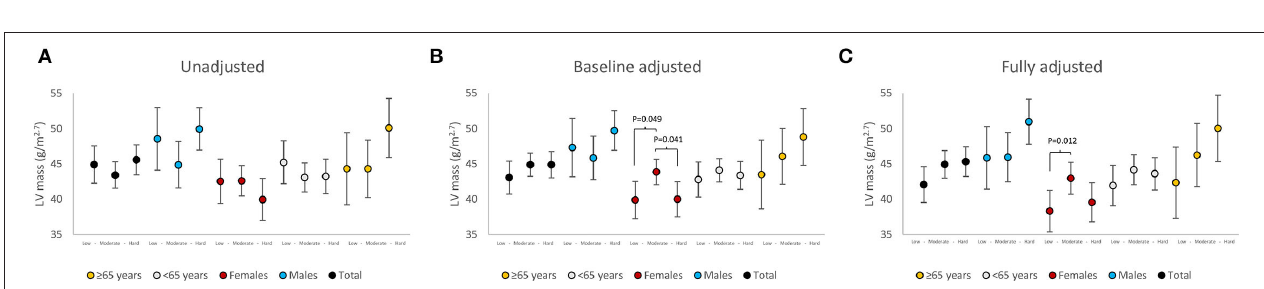
FIGURE 5 | Associations between cumulative PA and cross-sectional LV mass index (LVMi) in Tromsø7. (A) is unadjusted, (B) is adjusted for baseline LVMi in Tromsø6, (C) is adjusted for baseline LVMi in addition to age, sex, body mass index, and hypertension groups. Differences between groups of cumulative PA are indicated with p -values. Error bars indicate 95% CI. PA, physical activity; LV, left ventricle; CI, confidence interval.